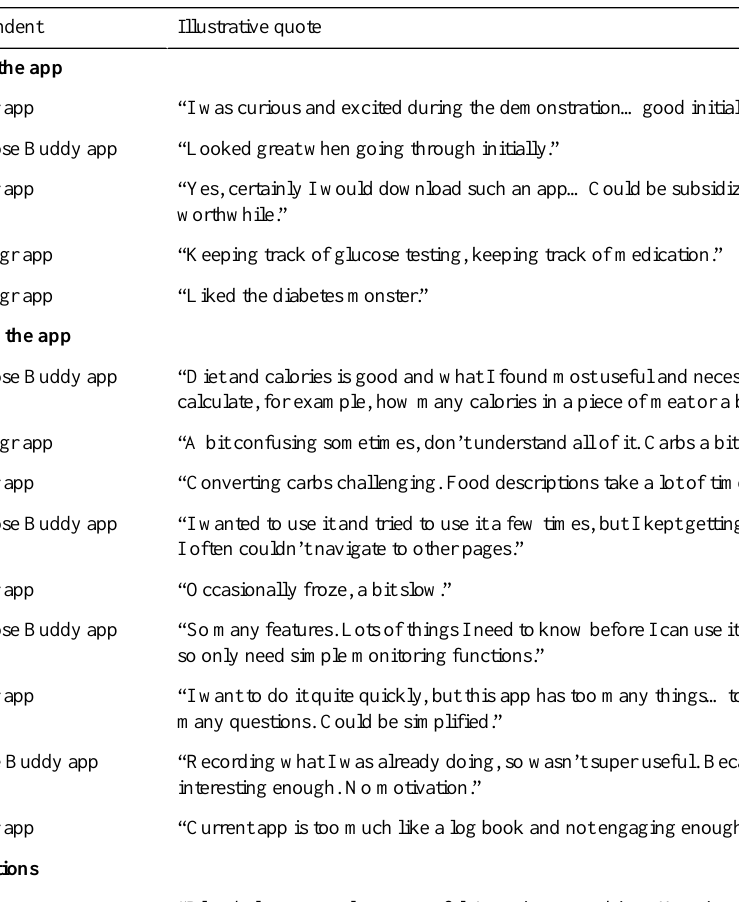
Table 4. Illustrative interviewee